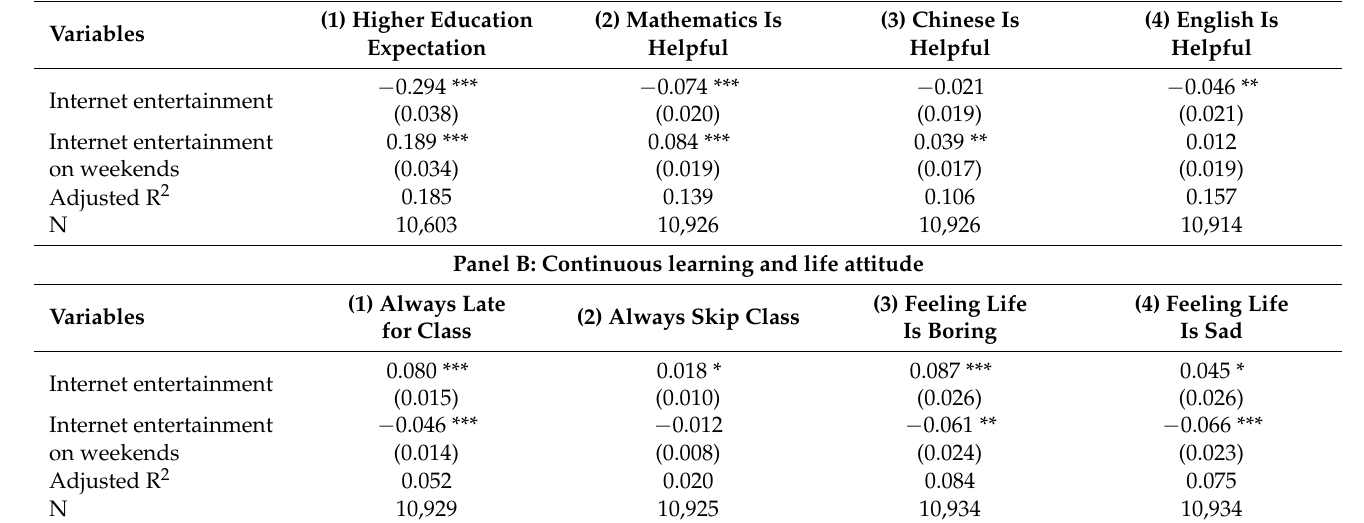
Table 7. Influence mechanism of internet entertainment on children’s cognitive ability. Panel A: Cognitive effort